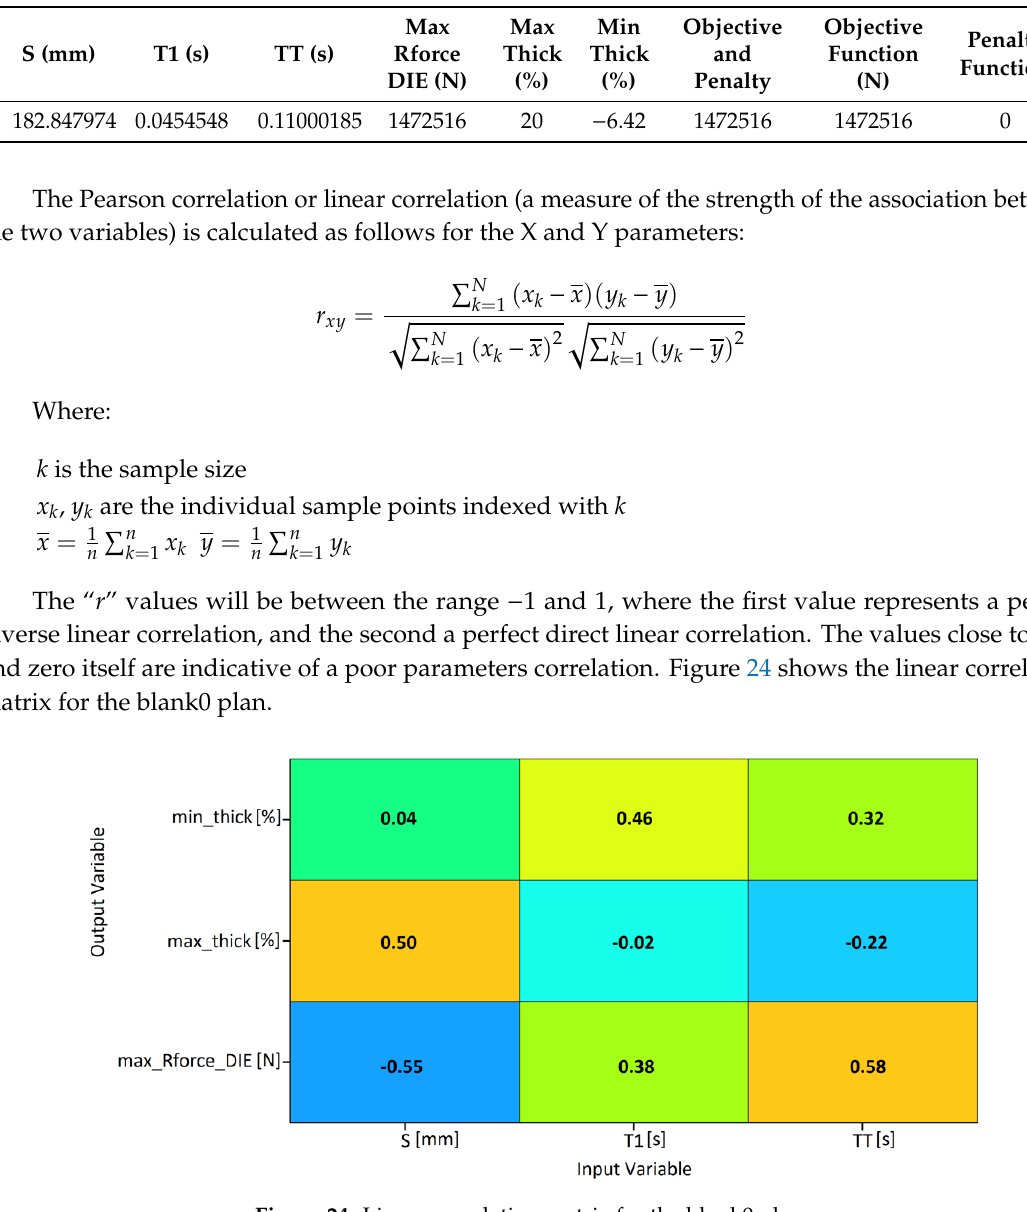
Figure 25. Design explored with multi-island genetic algorithm (MIGA), blank0 plan. 3.3. Definition and Resolution of the Optimization Problem for Blank1 As in the case of blank0, below is reported the optimization problem definition for the model blank1 plan. The optimization problem has been defined as follows: Objective Function: